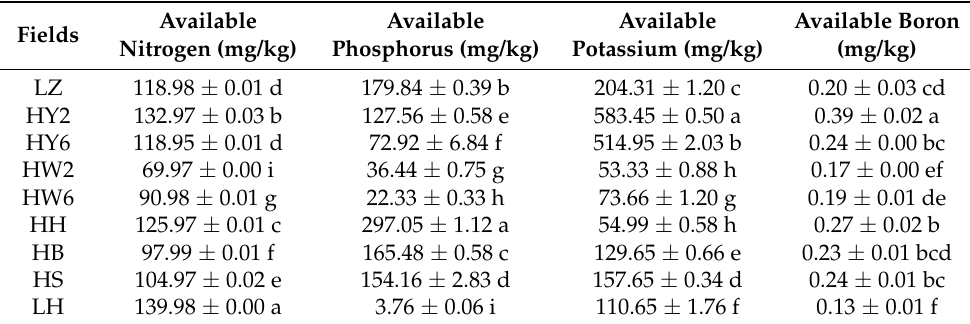
Table 1. Soil available N, P, K, and boron in different continuous cropping fields.